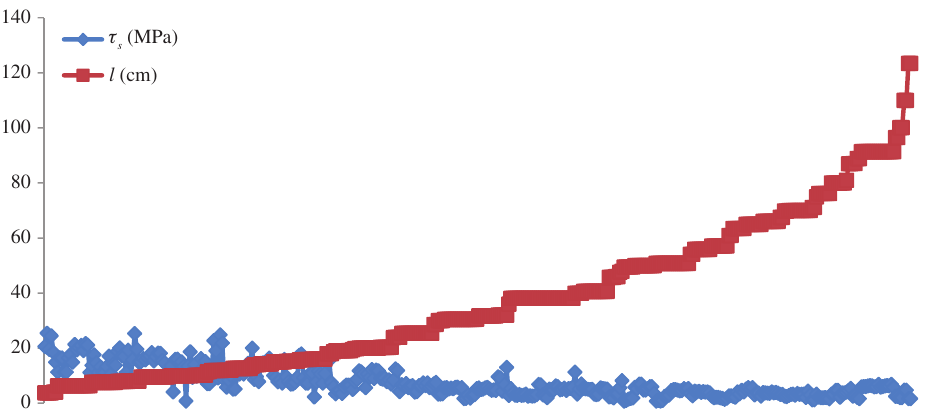
Figure 22: Change in the bond strength of FRP bars in concrete with changing embedment length.